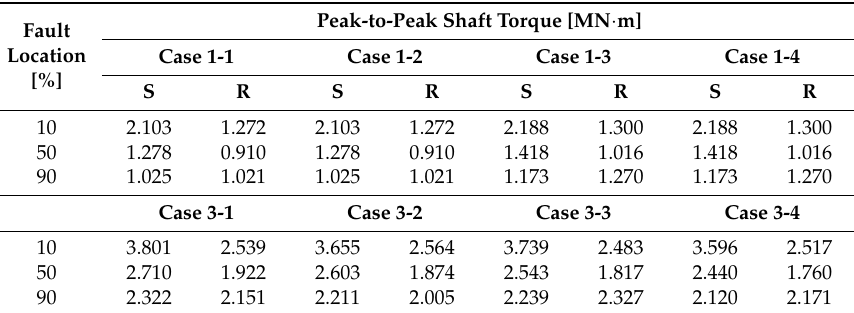
Table 2. Simulation result according to the 3-phase fault.